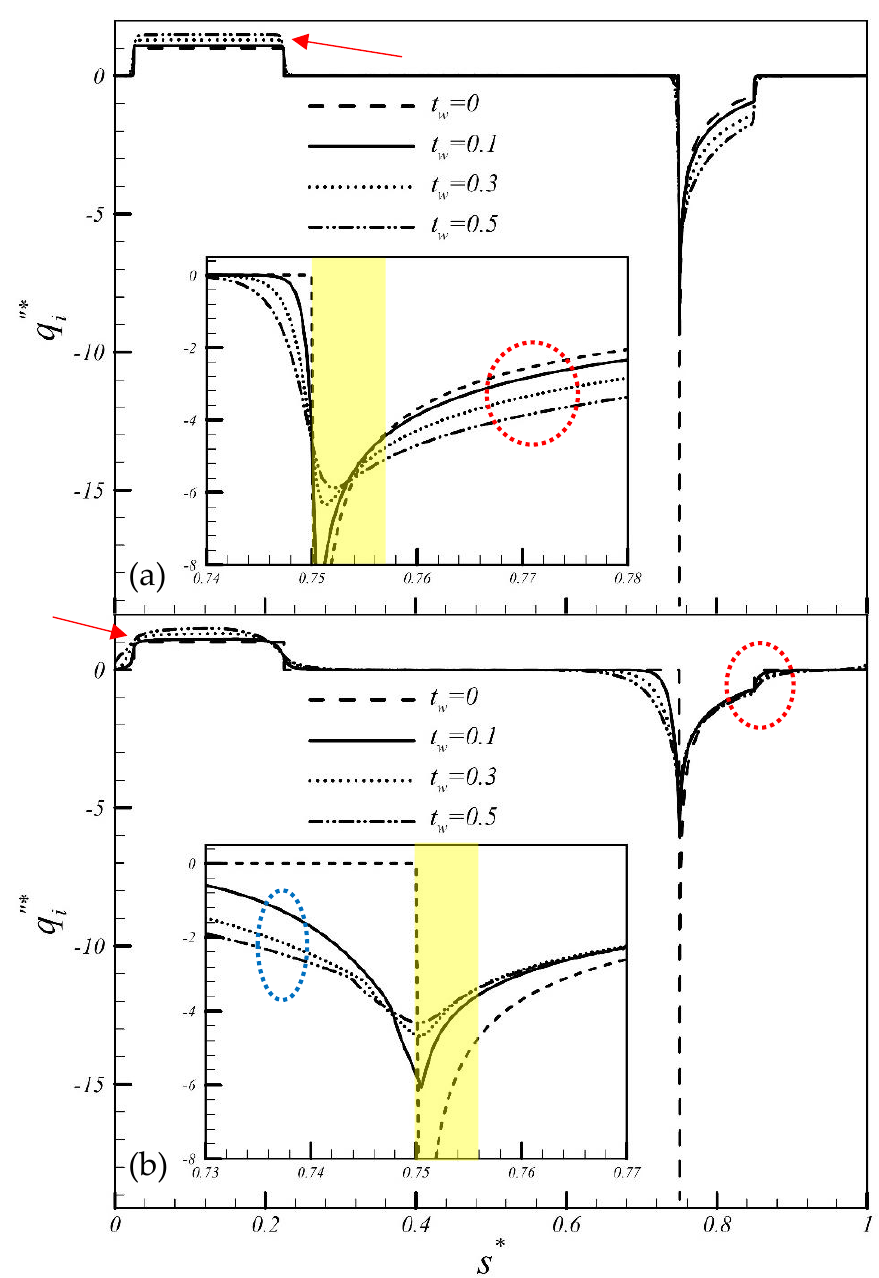
Figure 5. Effects of 𝑡 𝑤 on the 𝑞 𝑖”∗ distribution at various 𝑘 𝑤𝑓∗ (top: (a) 𝑘 𝑤𝑓∗ = 1; bottom: (b) 𝑘 𝑤𝑓∗ = 100) ( AR = 1, 𝑙 ℎ∗ = 0.8, 𝑙 𝑧 = 2, 𝑆𝑏 ∗ = 0.6, 𝑆𝑡𝑒 ∗ = 0.1, 𝑅𝑎 ∗ = 10 10 , and 𝑐 𝑣 = 10%).